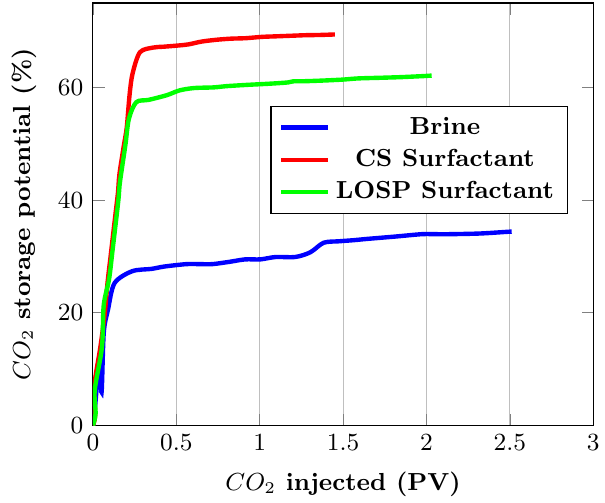
Figure 8. CO 2 storage capacity evaluated during injection with brine, CS, and LOSP surfactant solutions (Adapted from Yu et al.